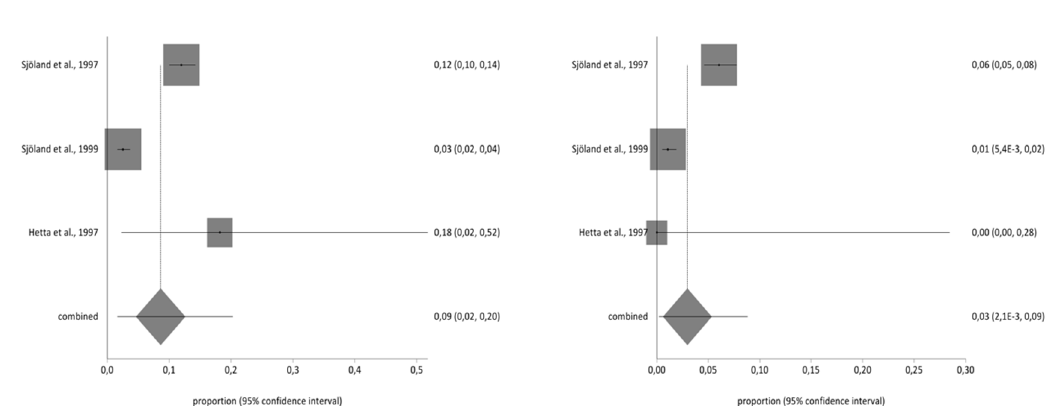
Figure 5. Pre- and Post-impact on family relationships.